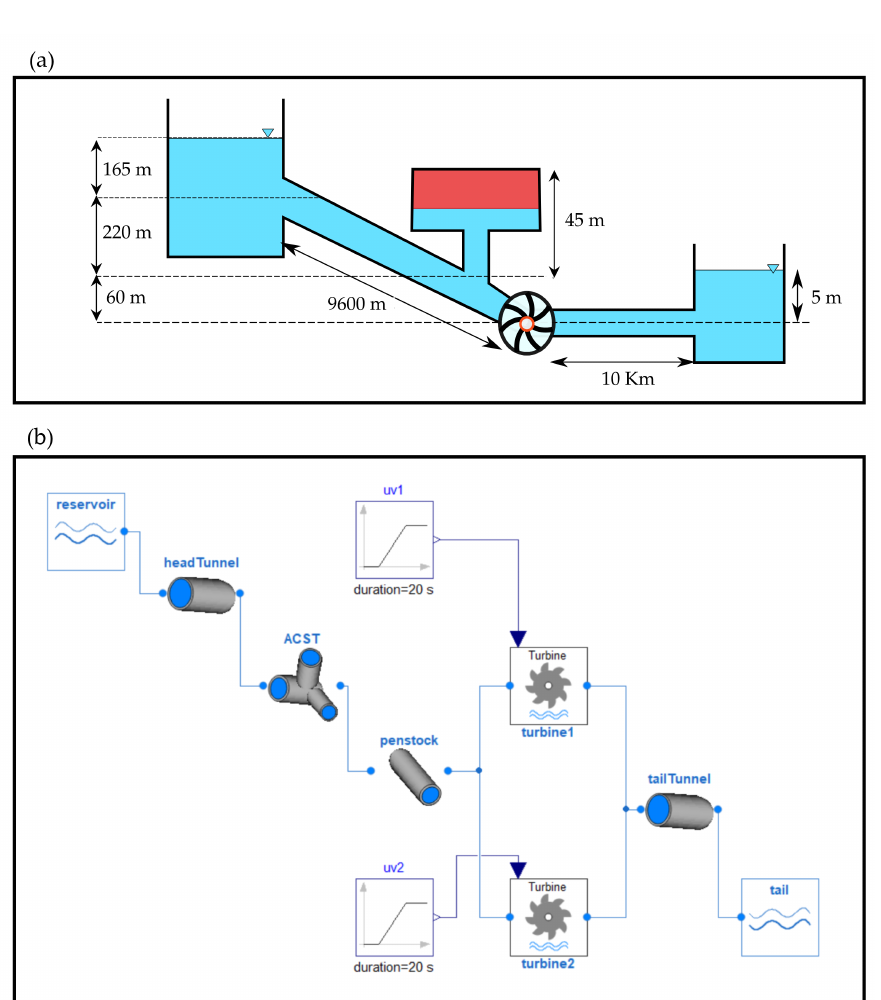
Figure 4. ( a ) Layout diagram for Torpa HPP. Nominal head, nominal discharge, and nominal power output are 445m, 40m 3 /s and 150MW, respectively. The ACST has air volume of 13,000 m 3 , initially pressurized at 41 · 10 5 Pa. Similarly, both of the headrace and tailrace tunnels are 7m in diameter. Torpa HPP consists of two turbine units each rated at 75MW with rated discharge at 20m 3 /s. Torpa HPP also consists of a tailrace surge tank not shown in the figure. ( b ) Simulation model of Torpa HPP implemented in OpenHPL from the head reservoir to the tail